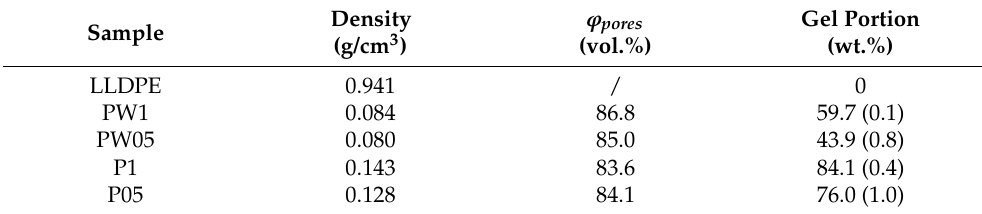
Table 3. The specific density, gel content, and volume portion of materials.